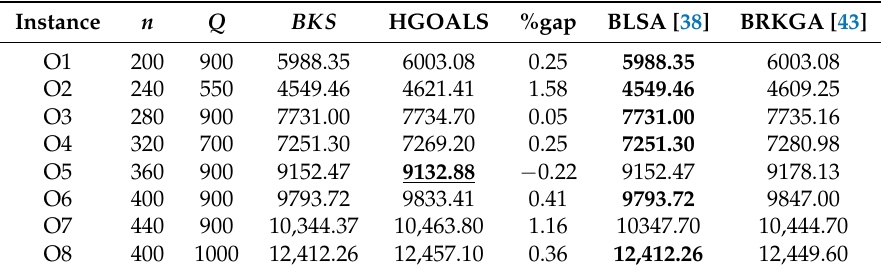
Table 8. Comparison between route decoder and previous research for instances in group O (minimizing traveling cost).